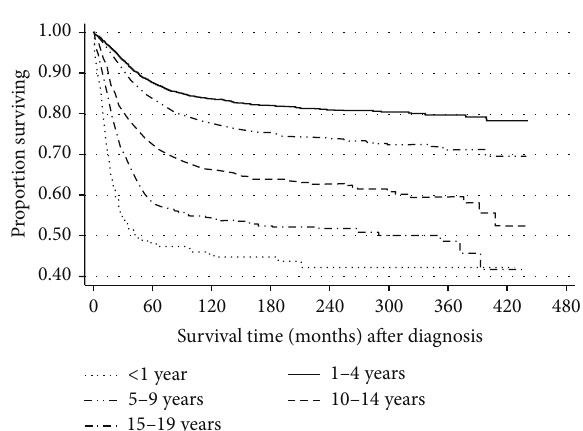
Figure 1: Kaplan-Meier pediatric ALL survival estimates by age at